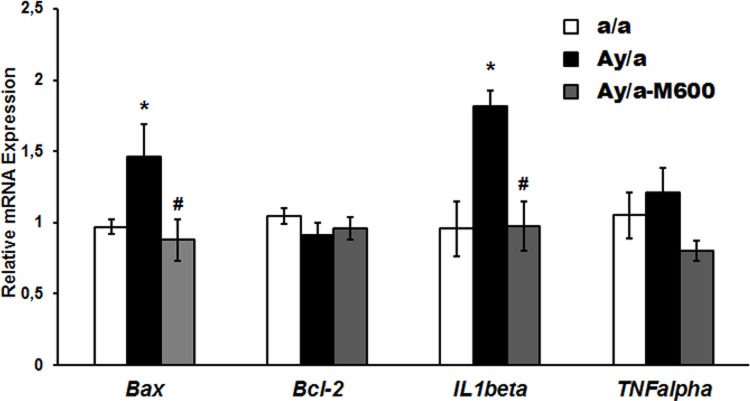
The gene expression of the proteins involved in apoptosis and inflammation in the liver of obese agouti-mice and the effect of metformin treatment.The levels of mRNA expression of the Bax, Bcl-2, IL1beta and TNFalpha genes encoding pro-apoptotic factor Bax, anti-apoptotic factor Bcl-2, the inflammatory cytokines interleukin 1β and TNFα are normalized by the expression of the reference 18s rRNA gene. The relative mRNA expression is calculated with the respect to control group. The data are presented as the M ± SEM, n = 5. *—the difference between the Groups a/a and Ay/a-M600 is significant at the P < 0.05, #—the difference between the Groups Ay/a and Ay/a-M600 is significant at the P < 0.05.